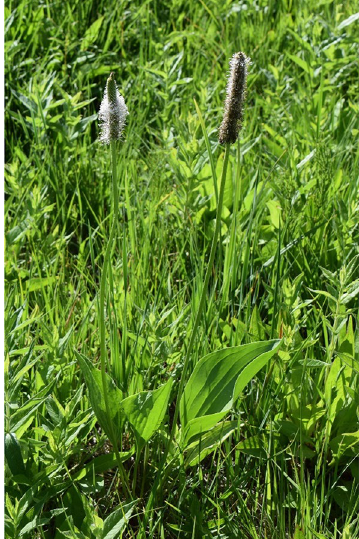
Fig. 4 Plantago maxima individuals flowering in the ex situ collection